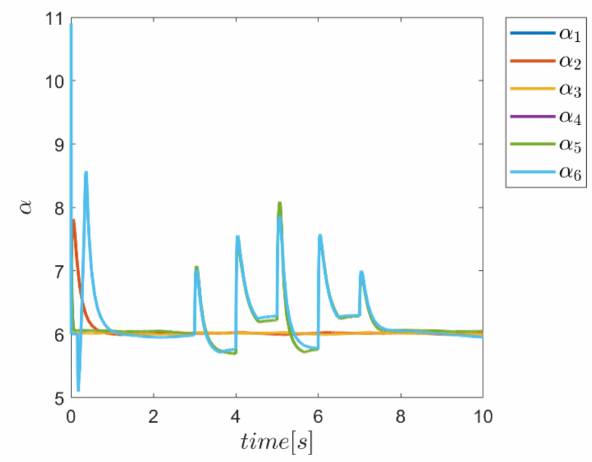
Figure 27. Adaptive variation of the coefficents of α for the combined α and Γ fuzzy